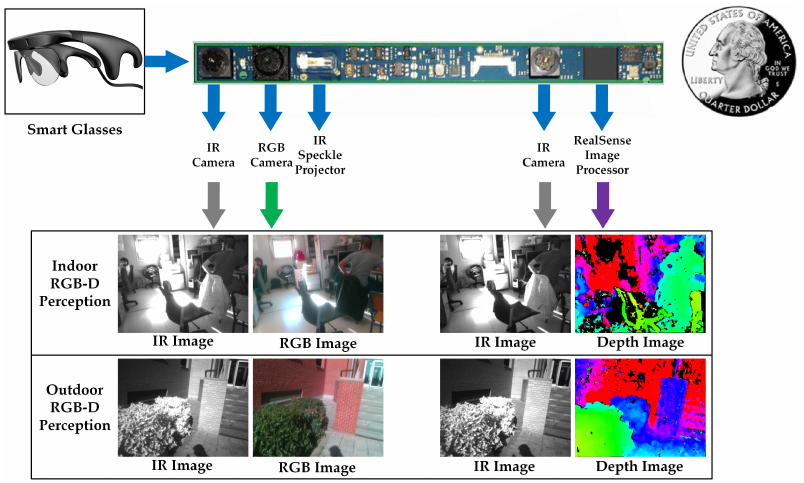
Figure 3. RGB-D perception of the smart glasses in indoor and outdoor environments.